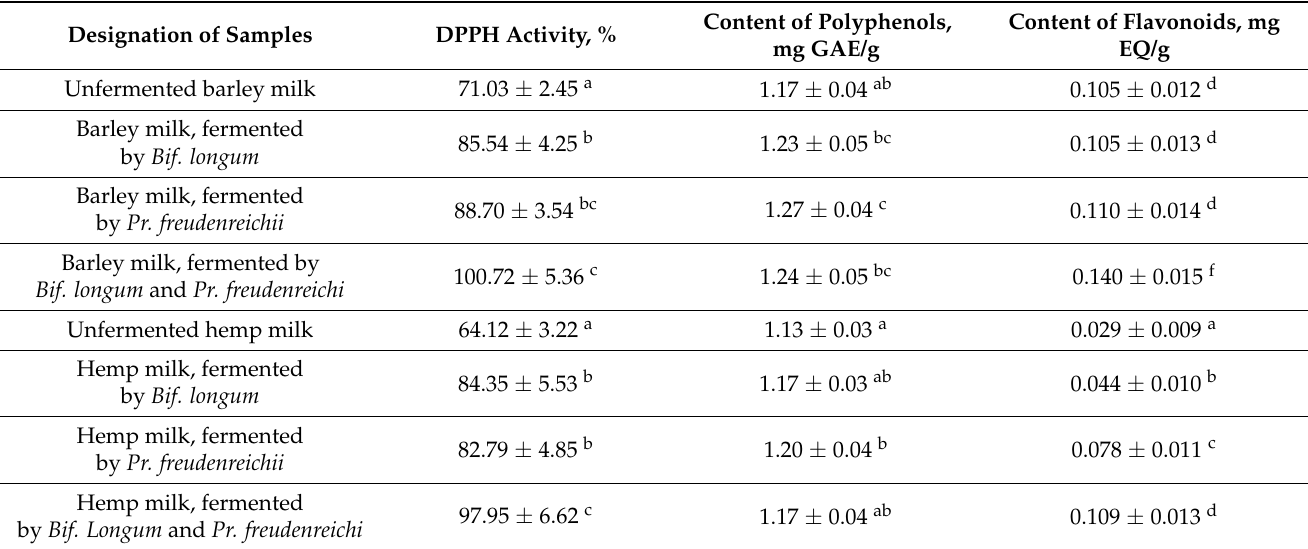
Table 3. The antioxidant activity and polyphenol content in the fermented grain-based